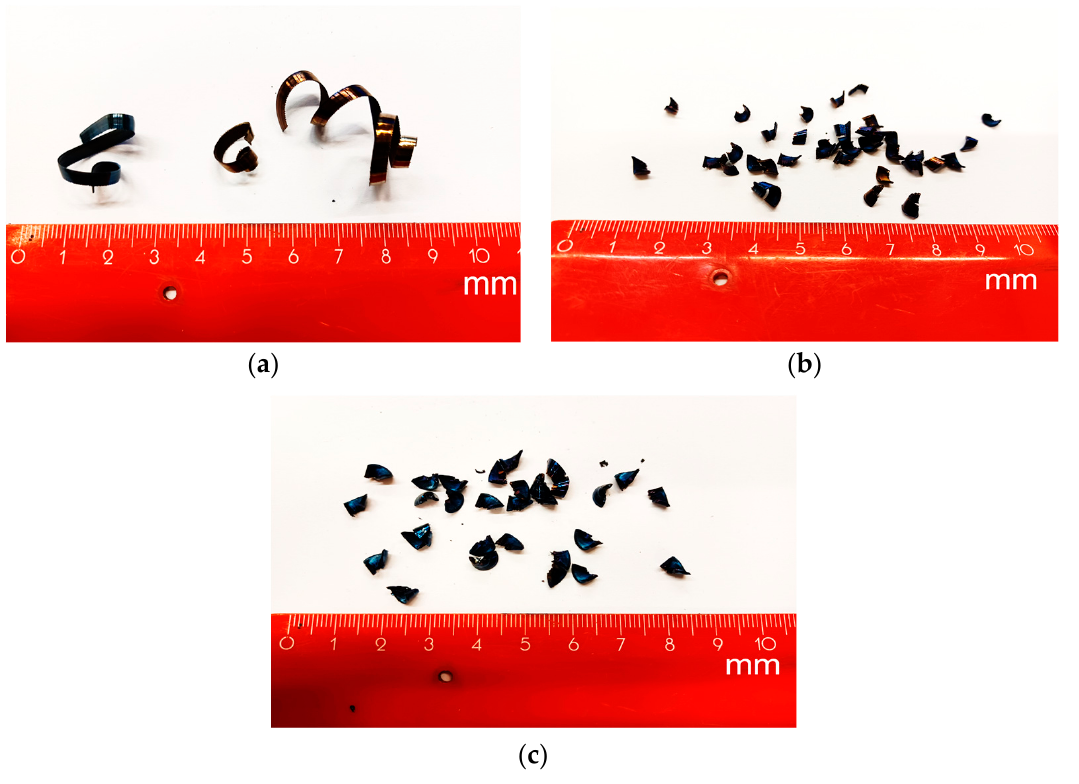
Figure 4. Chips after machining C45 medium carbon steel when v c = 180 m/min and feed: ( a ) f = 0.2 mm; ( b ) f = 0.4 mm; ( c ) f = 0.6 mm.